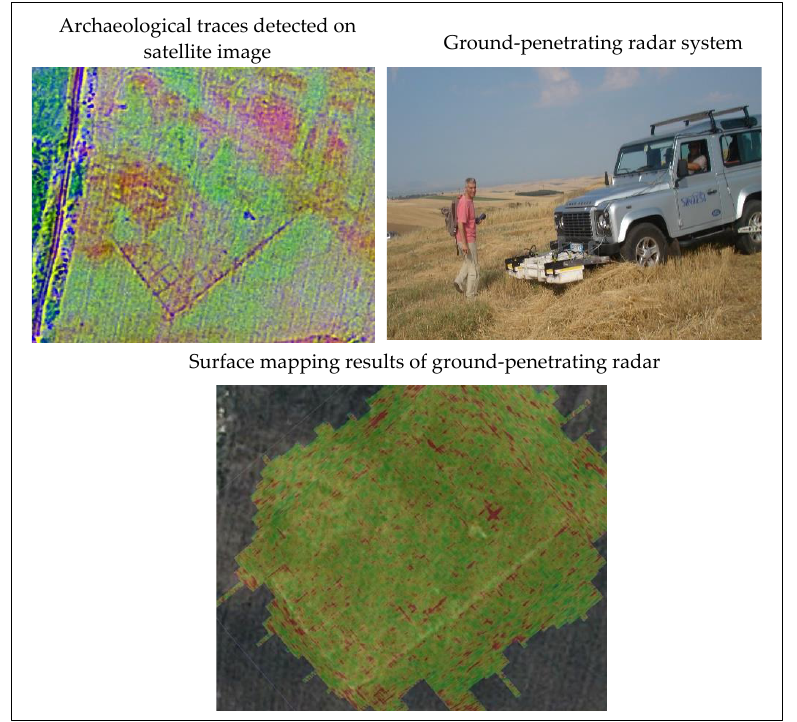
Figure 9. Mapping the subsoil using ground-penetrating radar.